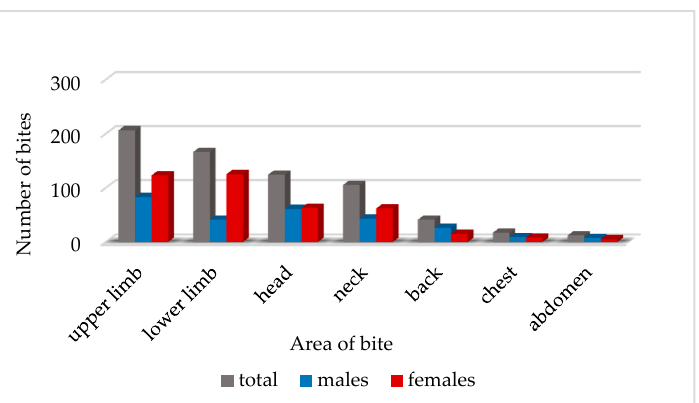
Figure 1. Number of blackfly bites on various parts of the patient’s body ( n = 671) in the group of females ( n = 401) and males ( n = 270); n —number of all blackfly bites noted in the study.